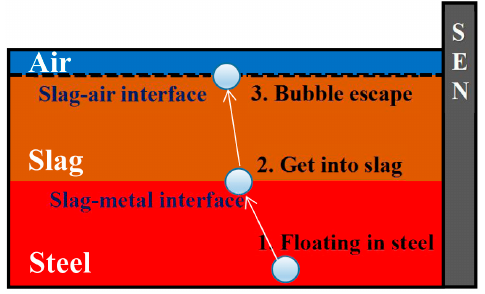
Figure 2. Bubble movements among different phases.